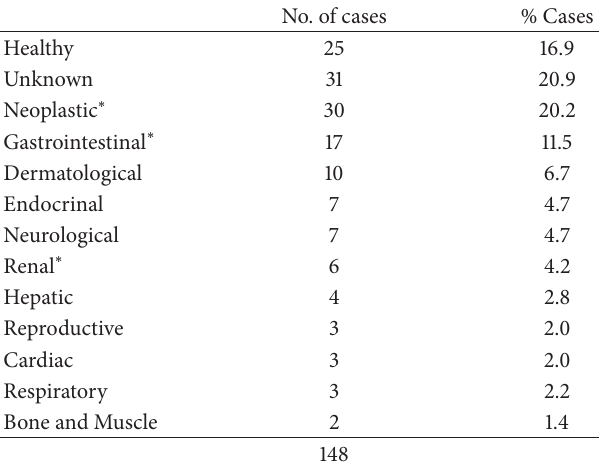
Table 3: Assignment of 139 dogs with qRBCs in healthy or diseased subgroup.